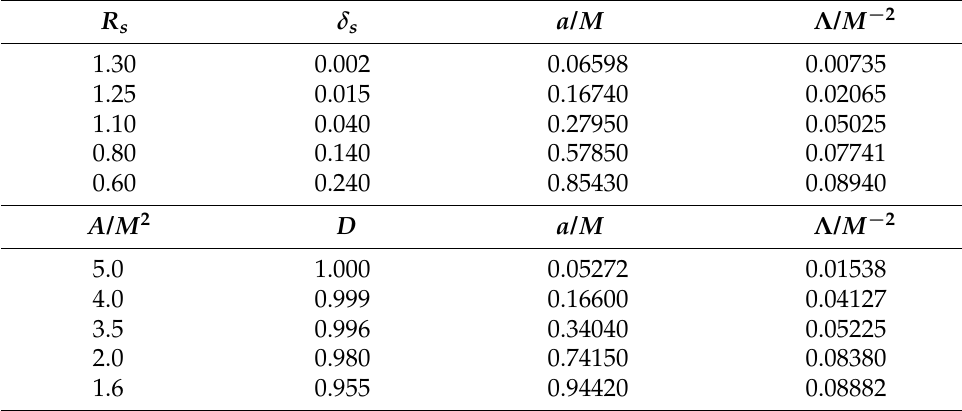
Table 1. Estimated parameters of new Kerr–de Sitter black